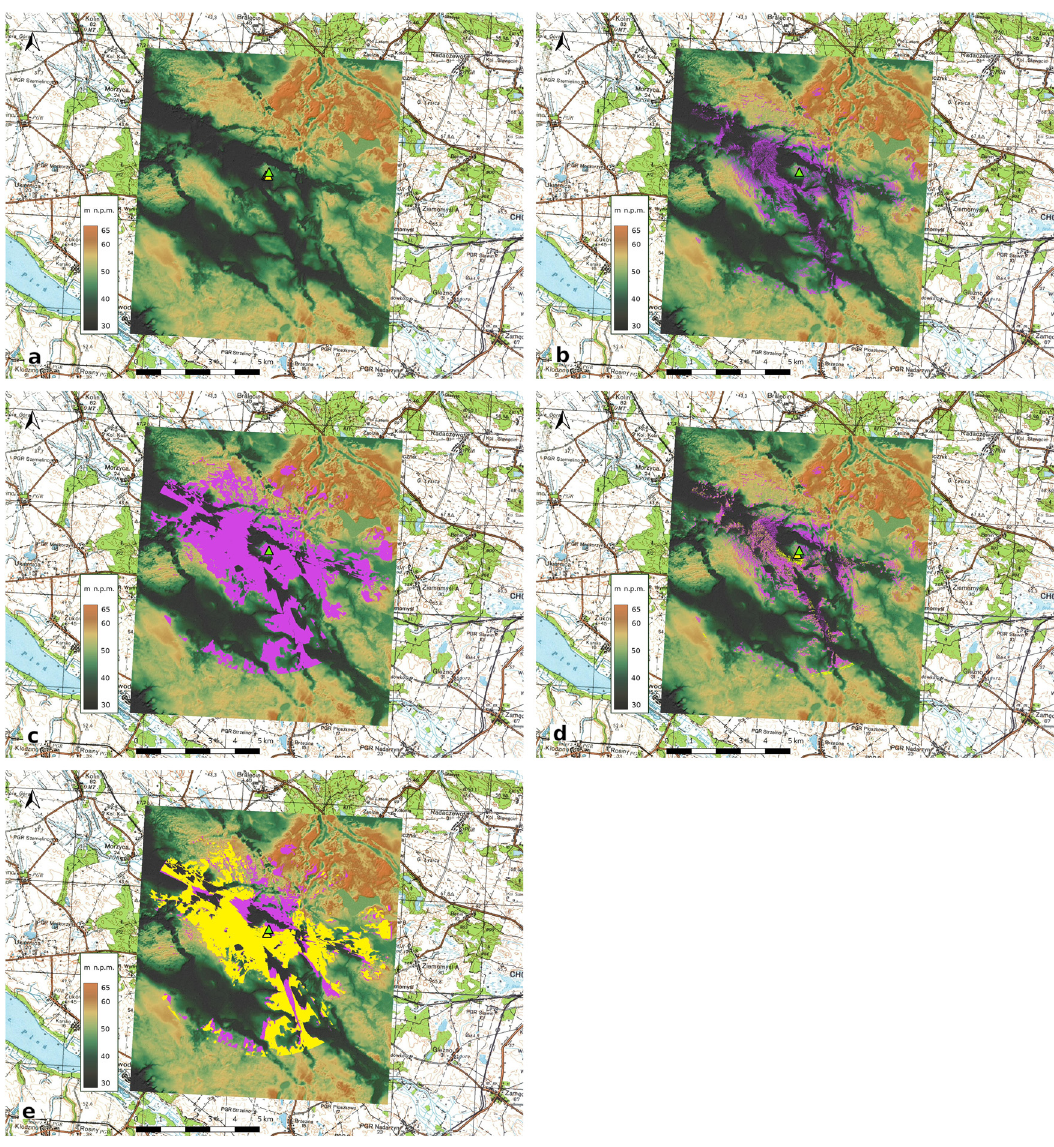
Figure 14: The point selected as optimal near the Dolice - Komorowo North megalithic group ( yellow triangle ) in terms of visibility from this location and this location from the surrounding area: location of the point [ green triangle ] ( a ) , the area visible from the point ( b ) , the area from which the point is visible ( c ) , the juxtaposed areas visible from the point and the tombs of the Dolice - Komorowo North megalithic group ( d ) and the juxtaposed areas from which the point and the tombs of the Dolice - Komorowo North megalithic group are visible ( e ) ( M. Schiller )